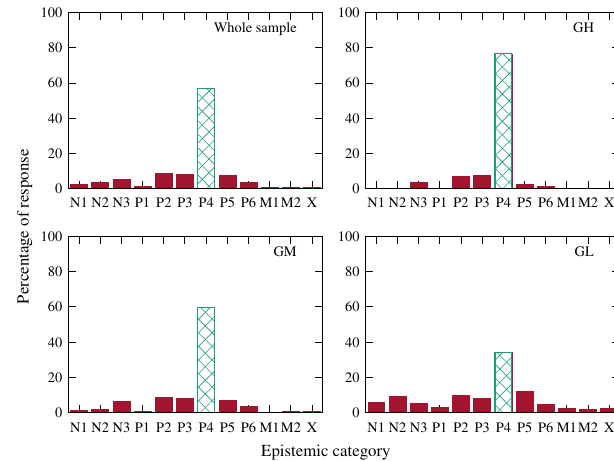
FIG. 9. Aggregate distribution of responses to all propositions (S2, S3, S11, S25, S29) corresponding to epistemic category P4. Format of the figure is the same as in Fig.